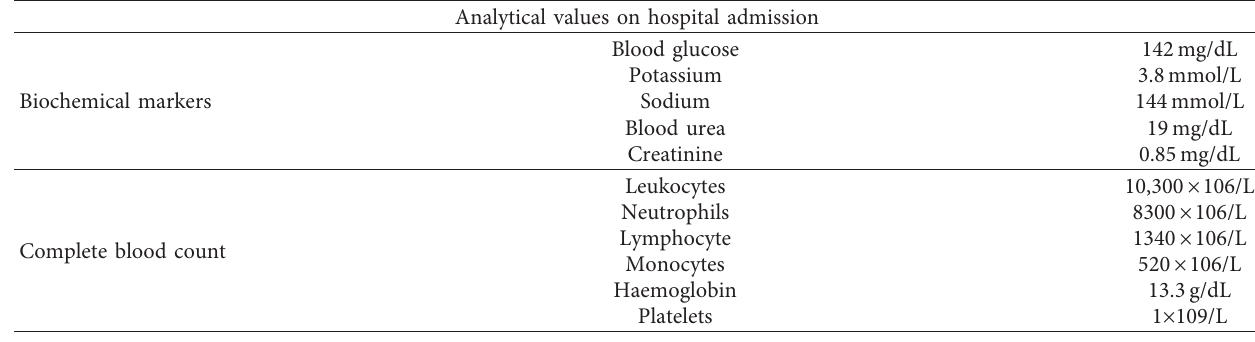
Table 1: Analytical values on hospital admission.